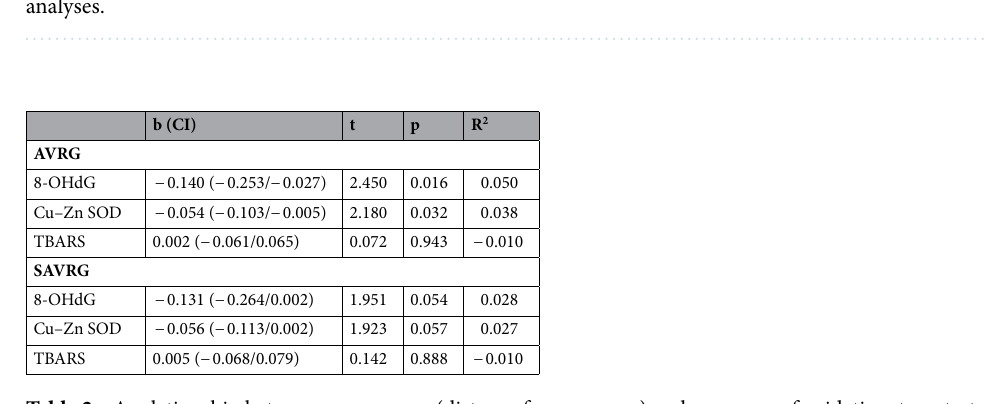
Table 2. A relationship between averageness (distance from average) and measures of oxidative stress tested by regression